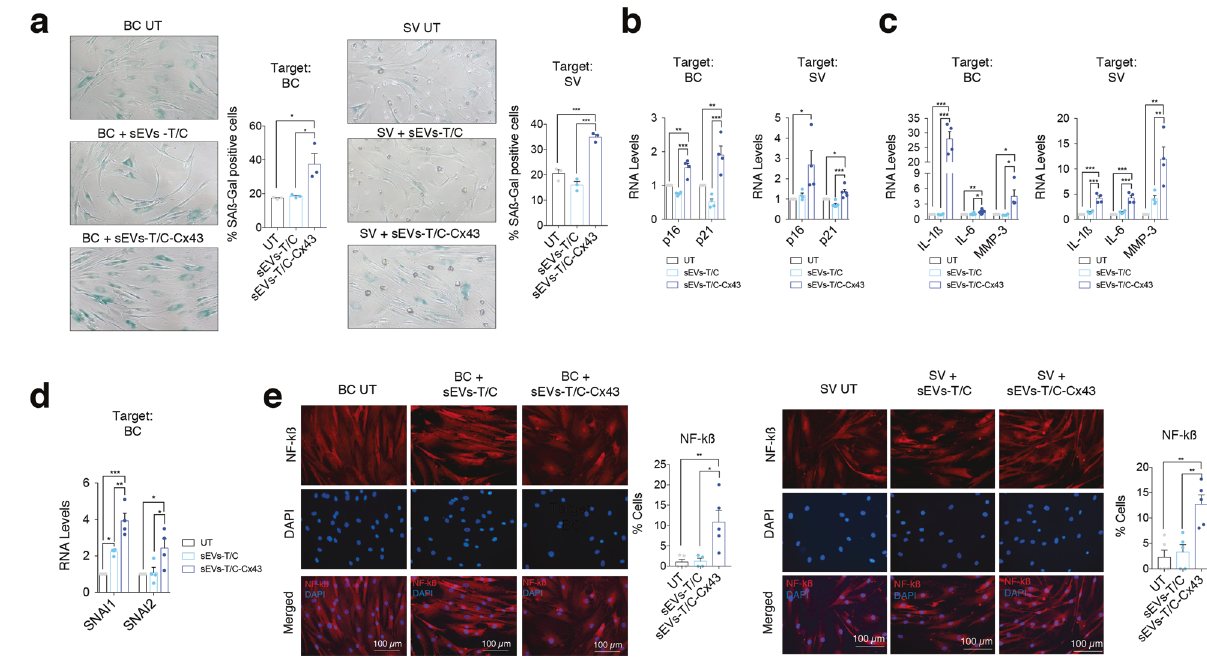
Fig. 9 sEVs derived from Cx43-overexpressing human chondrocytes promote OA-phenotype in bone and synovial cells. a Senescence- associated β -galactosidase activity (SA- β -Gal) levels were upregulated in both BC (left) and SV (right) treated for 48 h with sEVs derived from Cx43-overexpressing T/C-28a2 chondrocytes. n = 3, one-way ANOVA. b Treatment of BC (left, n = 4) and SV (right, n = 4 – 5) with sEVs derived from Cx43-overexpressing T/C-28a2 chondrocytes (sEVs-T/C-Cx43) for 48 h increased p16 and p21 gene expression levels. One-way